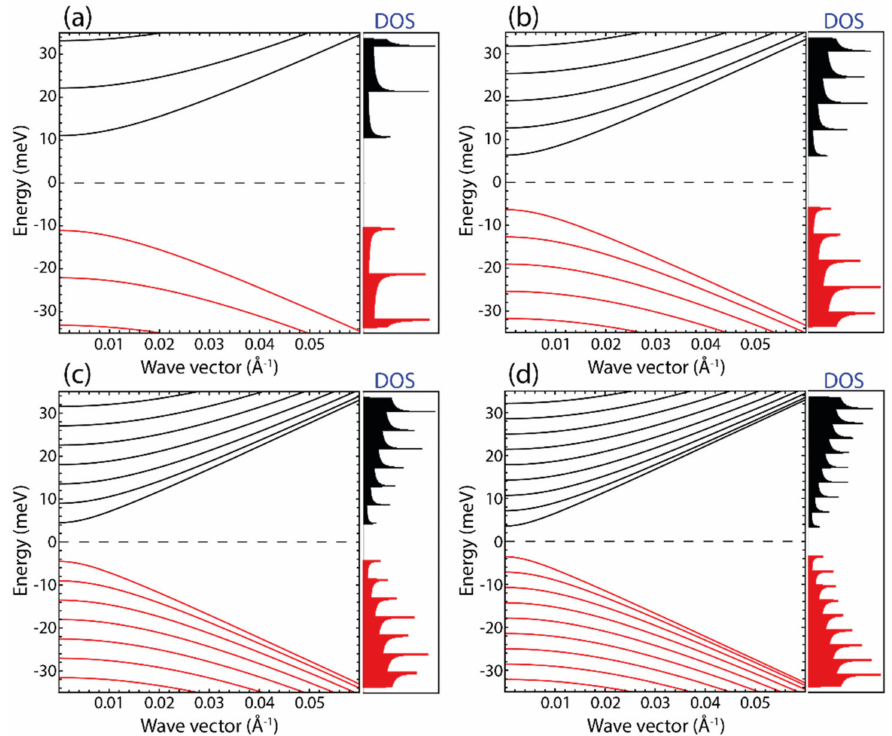
Figure 3. Band structure and density of states (DOS) as a function of wave vector ( k ) of the systems under study: ( a ) 155 nm, ( b ) 270 nm, ( c ) 380 nm, and ( d ) 480